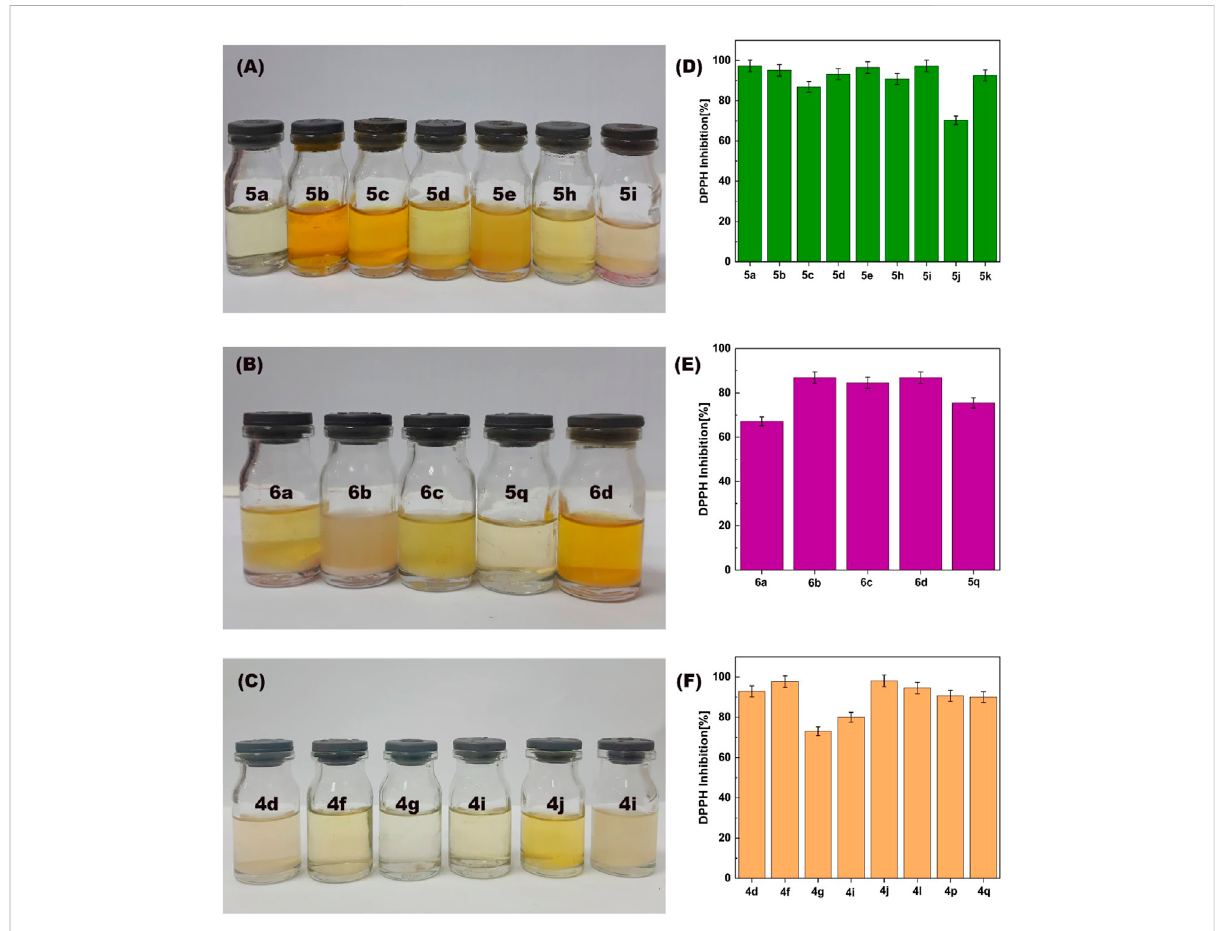
The photographs (A – C) and thehistograms (D – F) ofthe antioxidant activity ofsynthesized of1,4-dihydropyrano[2,3- c ]pyrazoles (4q, 4f,4g, 4i, 4d, and 4l), 4,4 ′ -(arylmethylene)bis(1H-pyrazole-5-ol) (5a, 5b, 5c, 5d, 5e, 5h, 5i and 5q), bis 4,4 ’ -(arylmethylene)bis(3-methyl-1H-pyrazol-5-ols) (6a, 6b, 6c, and 6d) derivatives.